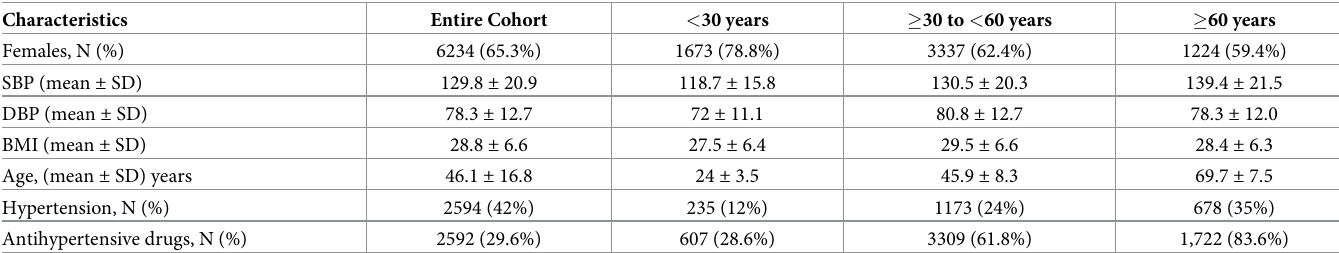
Table 2. Summary of demographic and clinical features of the entire cohort and stratified by age.